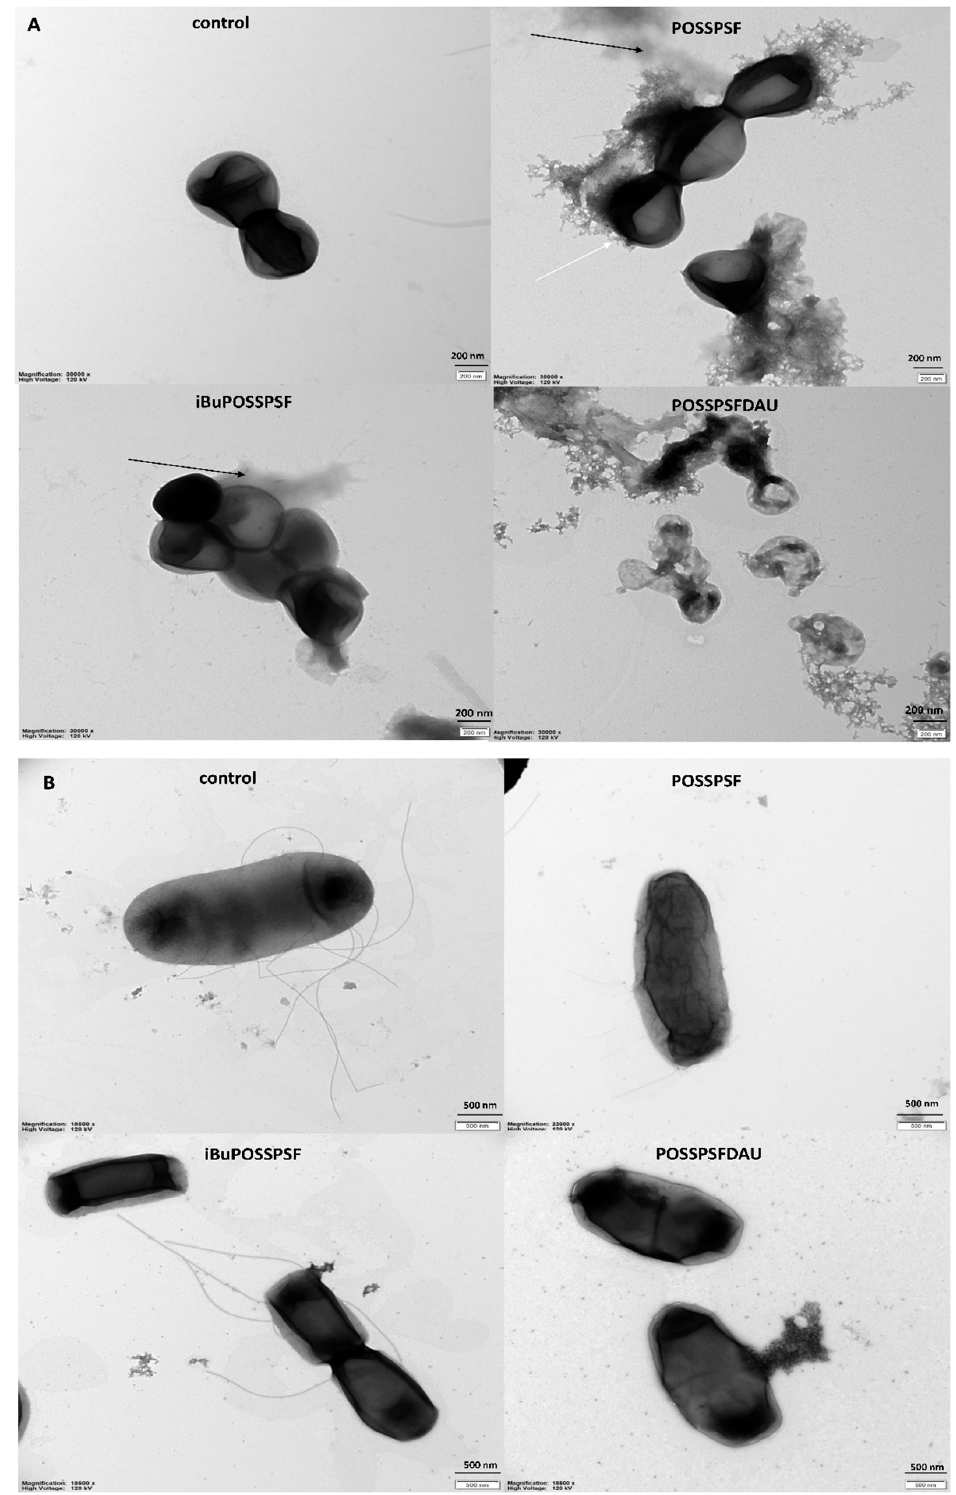
Figure 11. Transmission electron microscopy images of Staphylococcus aureus strain MRSA 12673 ( A ) and Escherichia coli 12519 ( B ) in the absence (control) and presence of POSSPSF, iBuPOSSPSF and POSSPSFDAU (green light irradiation ( λ em. max = 522 nm, irradiation = 10.6 mW/cm 2 ) for 5 min).